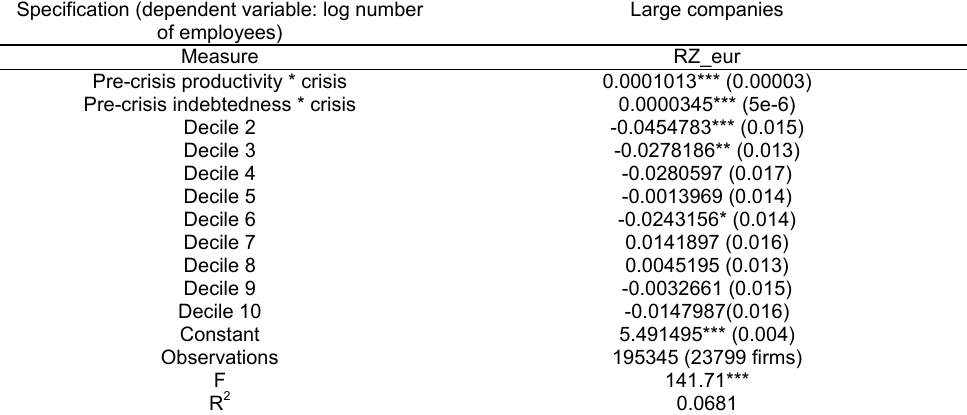
Table A.2. Results with decile